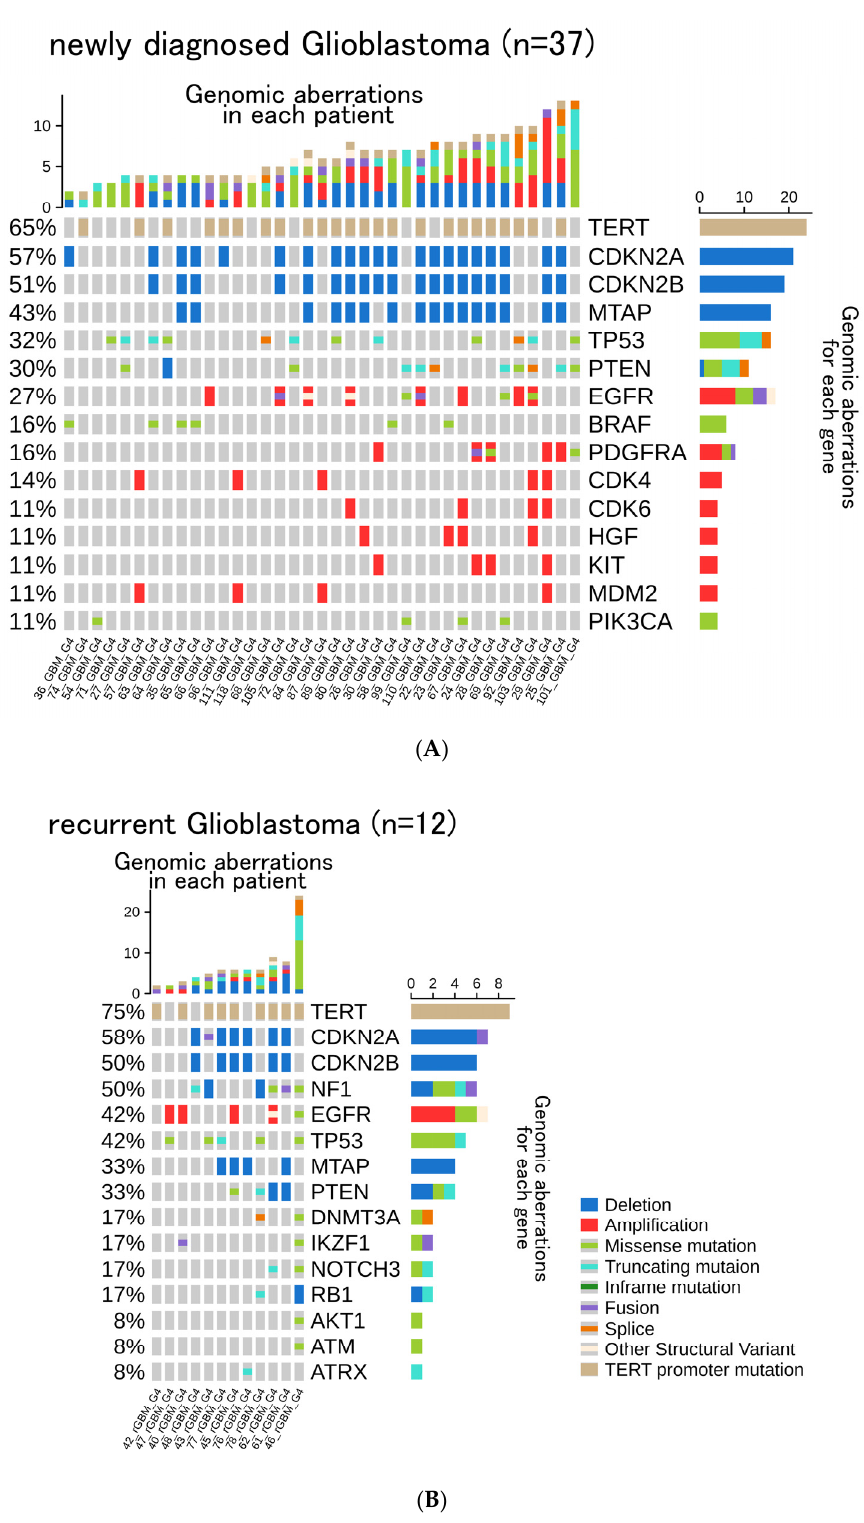
Figure 3. Oncoprint of ( A ) 37 patients with newly diagnosed IDH ‐ wt GBM; and ( B ) 12 patients with recurrent IDH ‐ wt GBM. The top 15 most frequently reported genes are displayed, respectively.